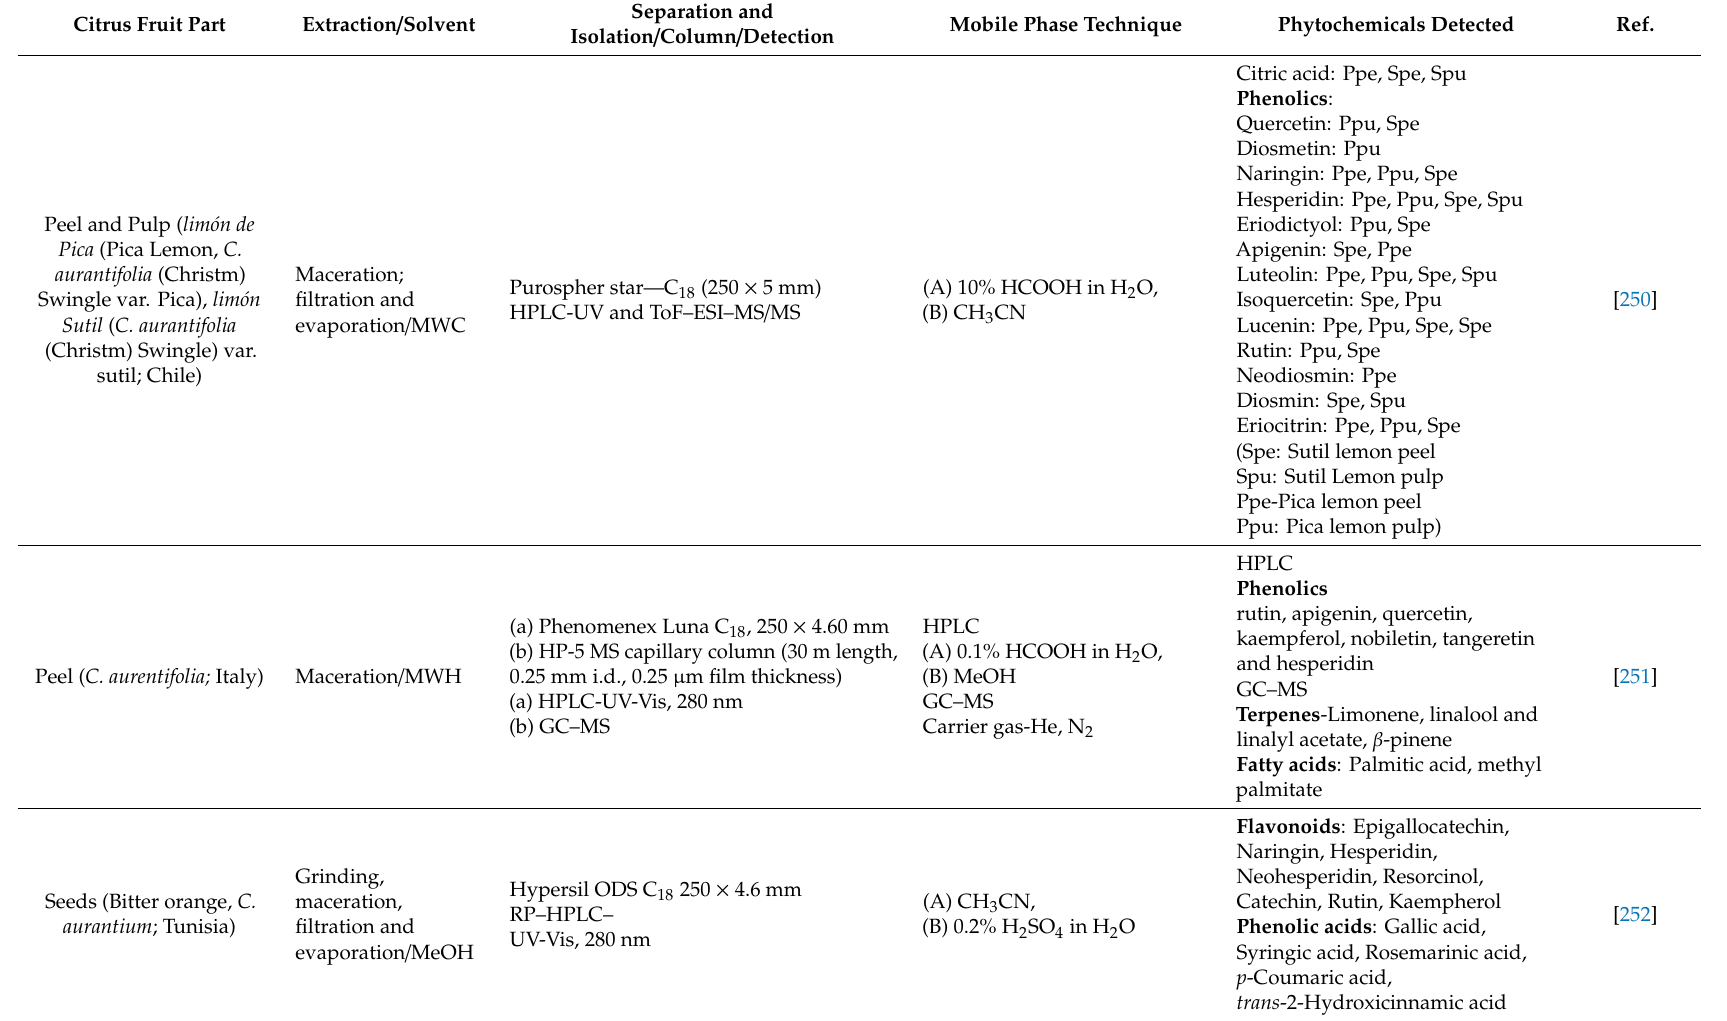
Table 14. Identification, determination, and analysis of citrus phytochemicals by chromatography assisted with spectroscopic techniques. Separation and Citrus Fruit Part